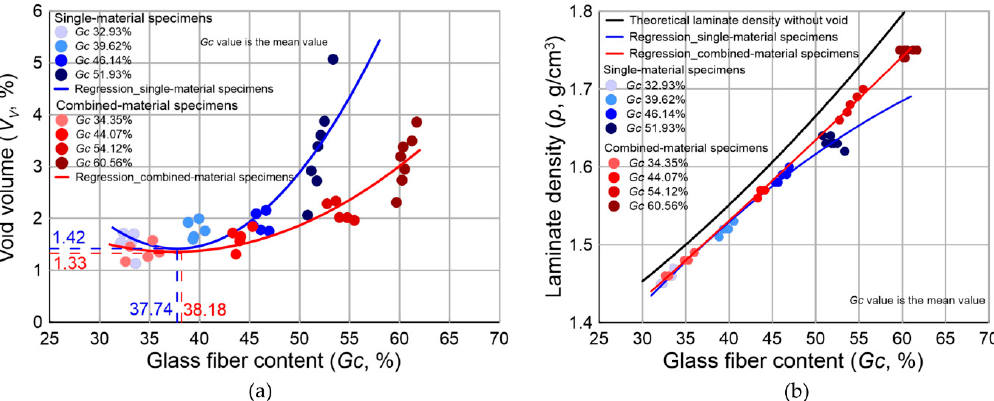
Figure 9. Variations of the ( a ) void volume with G c , and ( b ) relative density with G c with consideration of the void volume.